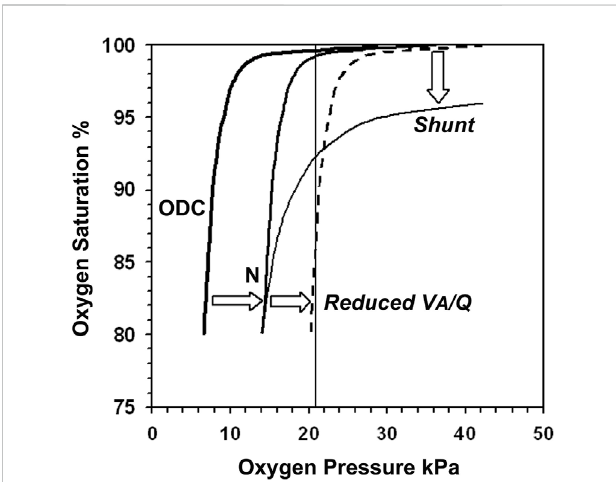
FIGURE 1 The neonatal oxyhaemoglobin dissociation curve is derived by plottingoxygensaturation(SaO 2 )againstarterialoxygenpressure(PaO 2 ) and determines the shape of the normal infant SpO 2 vs. P I O 2 curve (N), which is displaced to the right proportional to PCO 2 . Reducing Ventilation to Perfusion ratio (V A /Q) shifts the curve further to the right (dashed line). Its slope is now steep as it intersects the 21 kPa P I O 2 line where a 1% change in P I O 2 results in large SpO 2 instability. Shunt displaces the plateau downwards with trivial effect on